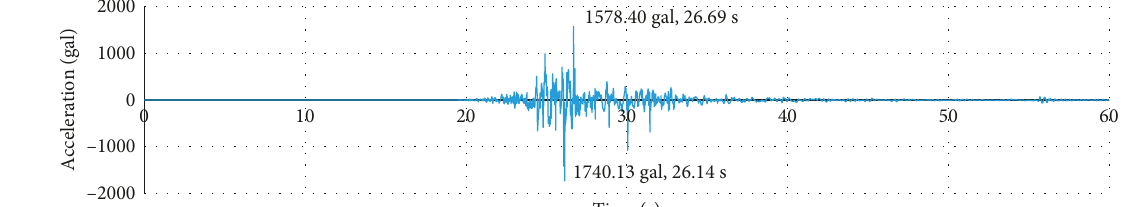
Figure 27: Earthquake input acceleration wave in the EW